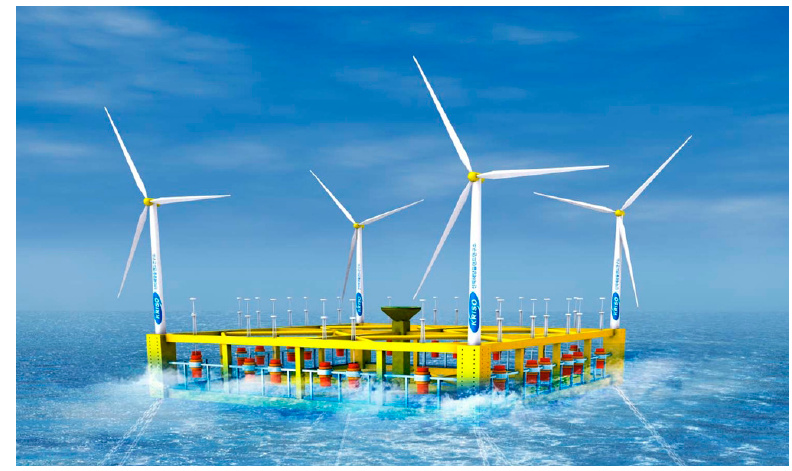
Figure 1. Wind-wave hybrid platform concept.